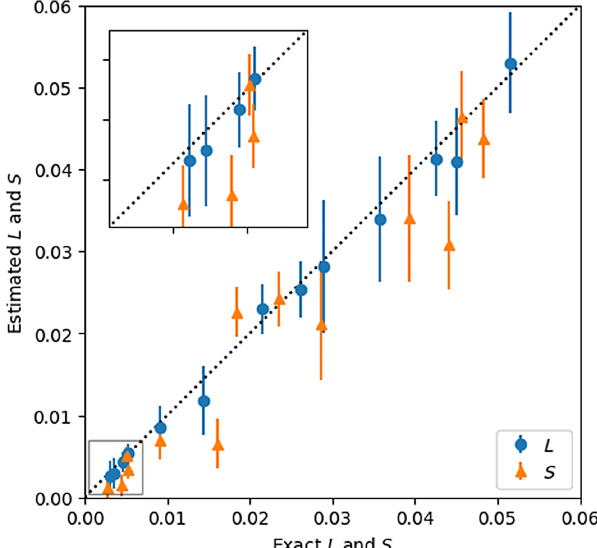
FIG. 6. The exact and estimated leakage and seepage for a selection of randomly generated error channels. Each estimate is based on data taken over 15 different lengths N . Each estimate is arrived at by applying a total of 300 000 unitary group ele- ments. The diagonal line denotes the points where the exact and estimated fidelities are equal. The data agree with this line with a reduced χ 2 value of 1.3, indicating good